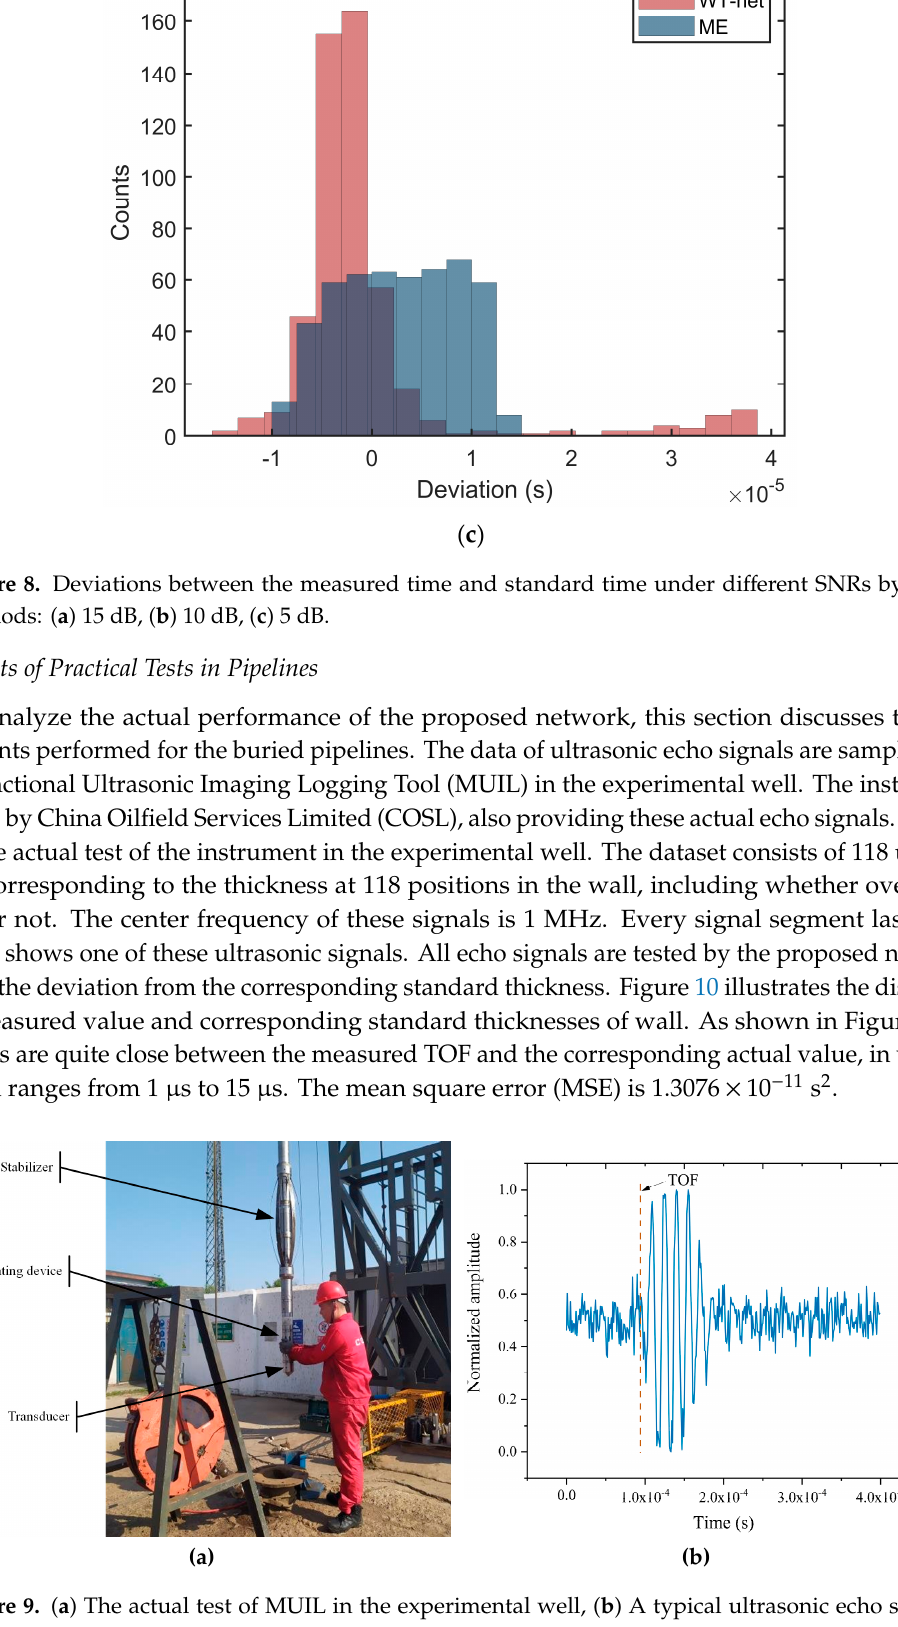
Figure 9. ( a ) The actual test of MUIL in the experimental well, ( b ) A typical ultrasonic echo signal collected by